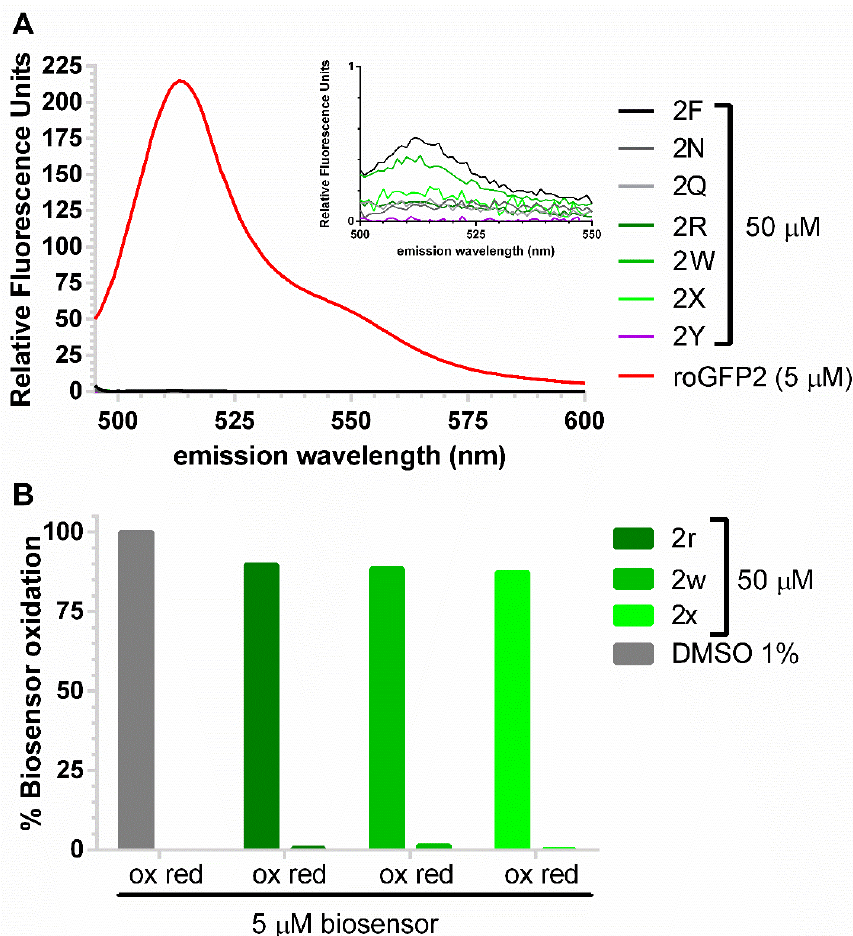
Figure 2. Fluorometric analyses of T. brucei ’s hit compounds: ( A ) Emission spectra ( λ ex = 488 nm) of the recombinant biosensor (5 μ M, roGFP2) in 1% v / v DMSO. Inset: zoom ‐ in of the emission spectra ( λ em = 500–550 nm) of the hit compounds (50 μ M) acquired under the same conditions. ( B ) Bars represent the percentage of biosensor oxidation based on the fluorescence emission of roGFP2. The oxidized (ox) and reduced (red) forms of the recombinant biosensor (5 μ M) were incubated for 1 h with 50 μ M 2r , 2w , or 2x dissolved in 1% v/v DMSO (for further technical details see Section 2.2.6).